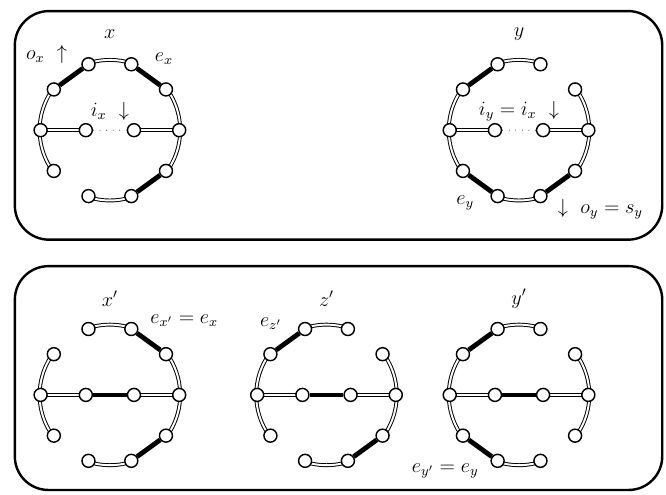
Figure 11: Case 4. a .iv, case 4. b .iv and case 4. c .iv. Figure 11. Case 4. a .iv, case 4. b .iv, and case 4. c